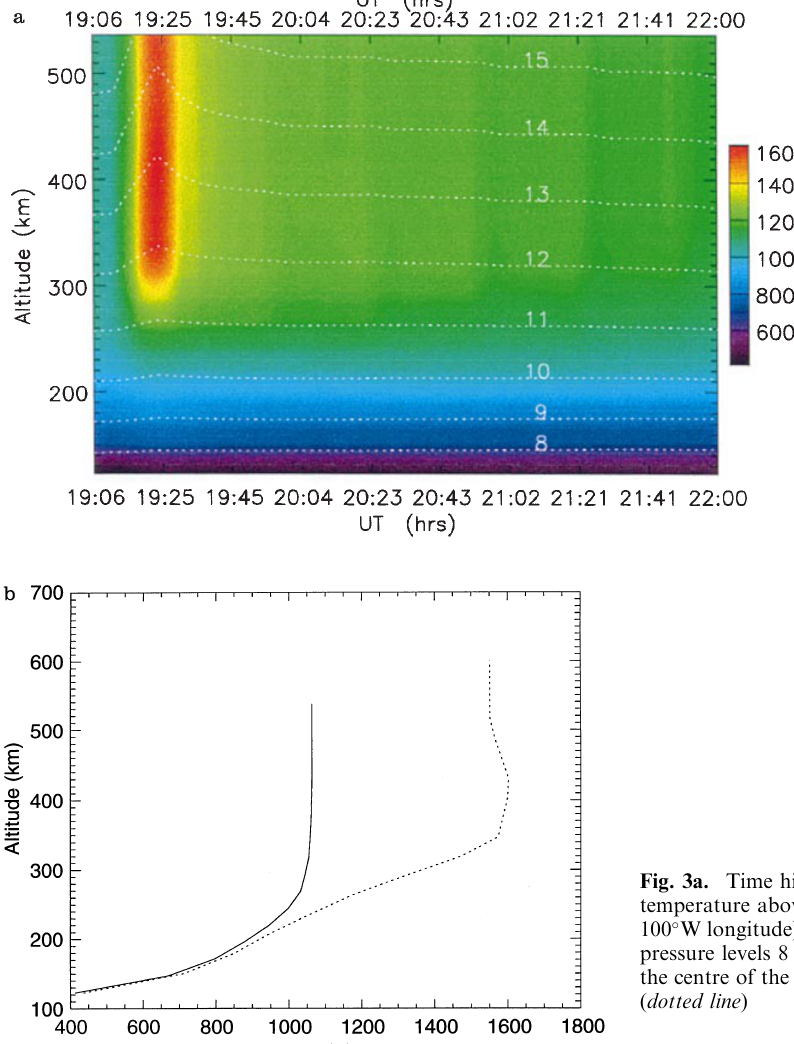
Fig. 3a. Time history plot of the altitude profile of the neutral temperature above the centre of the dayside throat (70 (cid:14) latitude, 100 (cid:14) W longitude). The white dotted lines show the heights of the fixed pressure levels 8 to 15. b Altitude profiles of neutral temperature at the centre of the dayside throat at 1906 UT ( solid line ) and 1924 UT ( dotted